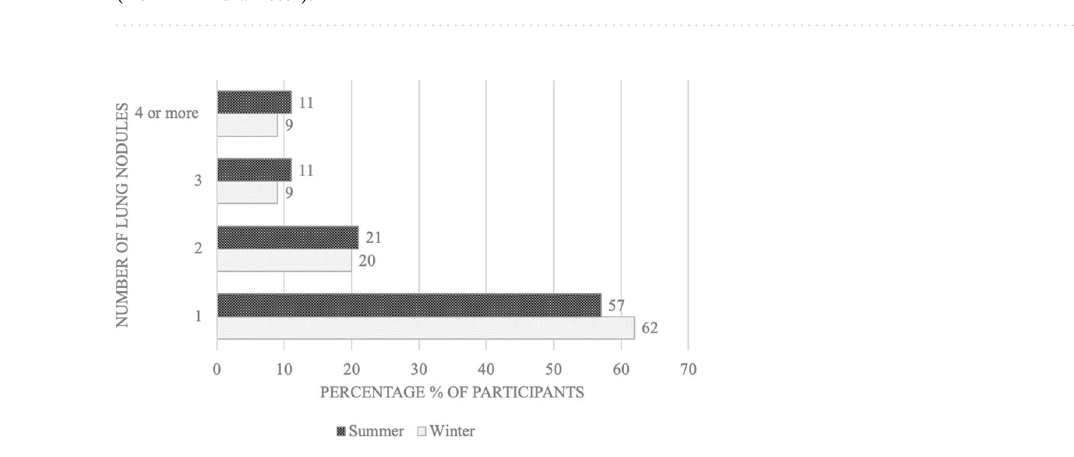
Figure 1. Percentage of participants per season with 1, 2, 3, or 4 or more